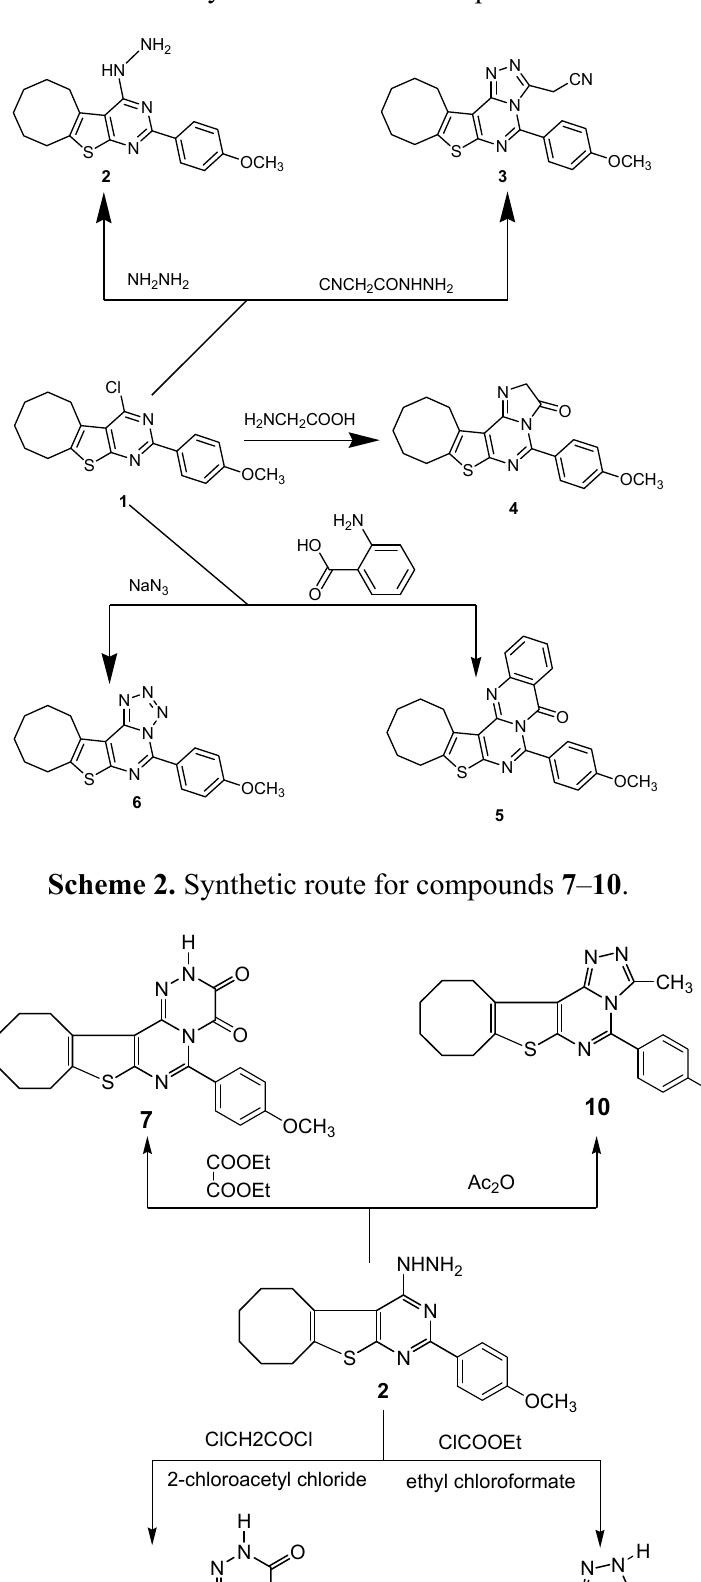
Scheme 1. Synthetic route for compounds 2 – 6 .